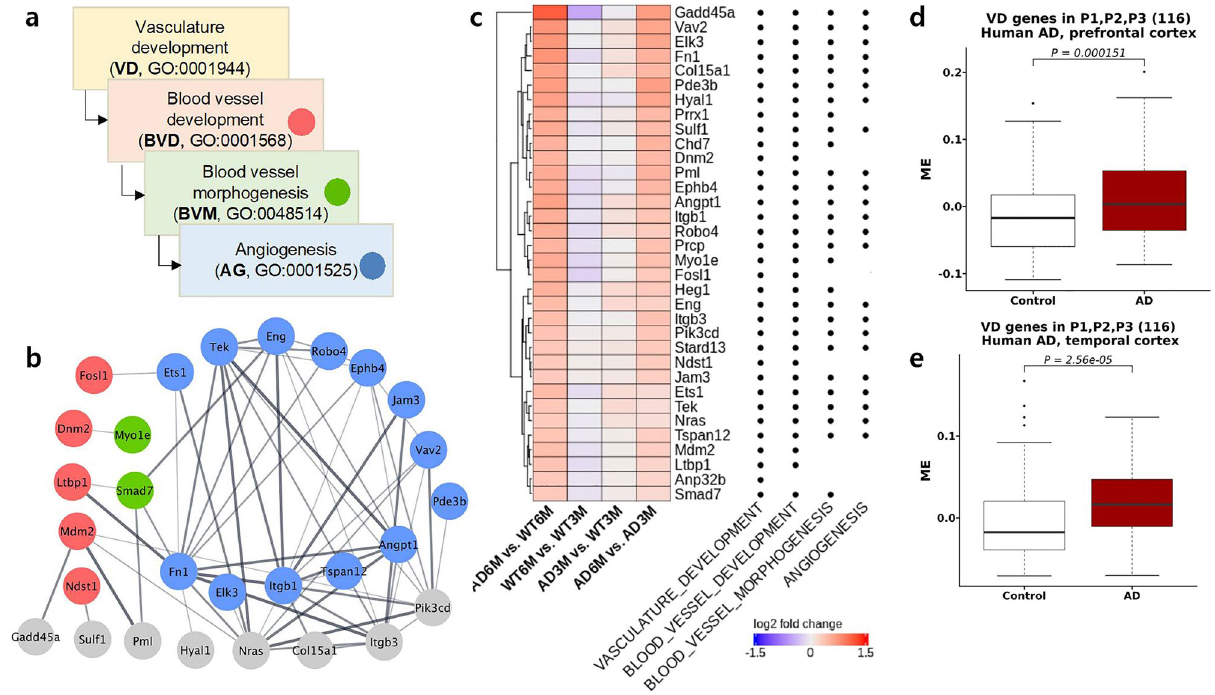
Figure 4. In-depth analysis of angiogenesis. ( a ) Gene Ontology tree of angiogenesis-related processes. ( b ) Protein ‒ protein interactions among the 20 VD genes with associated GO pathways (according to the colour code in ( a )). ( c ) Gene expression heatmap for log2 fold changes of 34 VD genes in four comparative pairs. ( d , e ) Module eigengenes (MEs) for 116 VD genes in P1, P2, and P3 in the human AD prefrontal cortex (ROSMAP) and temporal cortex (Mayo Clinic). VD, vasculature development; ME, module